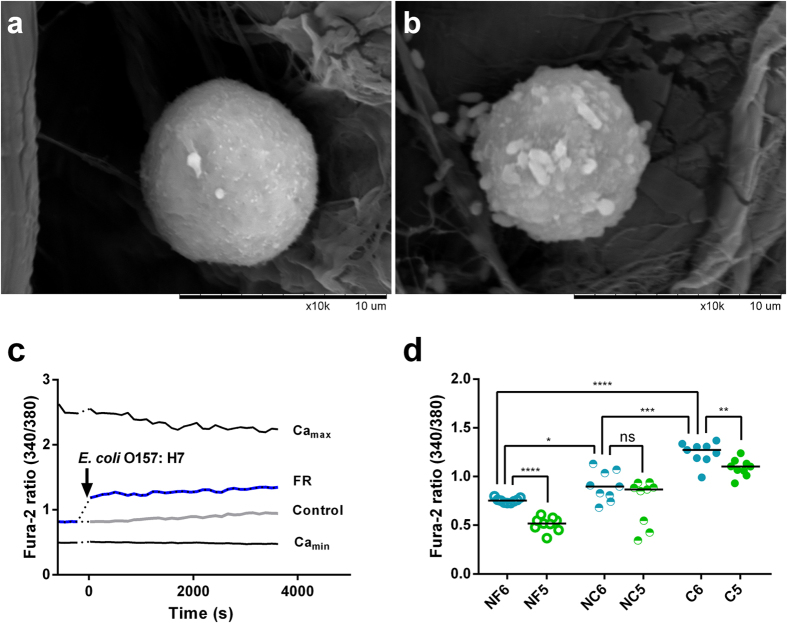
Optimization of the B cell biosensor. (a). SEM image of a B cell in the absence of any bacteria (×10000). (b). SEM image of a B cell with E.coli O157:H7 cells (×10000). (c). Real time response profile of Fura-2 340/380 ratio. (d). Comparison of the Fura-2 ratio for each group defined in the text. Data points represent the ratio of the stimulation by each concentration of E. coli O157:H7 (101-109 CFU/mL) in the group at the same time. Bars indicate the medians and p-value obtained by paired t-test. (two-tailed, nsp > 0.05, *p < 0.05, **p < 0.01, ***p < 0.001, ****p < 0.0001, n = 9) NF6: B cells (no Fura-2, Ca2+ and Mg2+ HBSS), 106 cells/mL. NF5: B cells (no Fura-2, Ca2+ and Mg2+ HBSS), 105 cells/mL. NC6: B cells (Fura-2, Ca2+ and Mg2+-free HBSS), 106 cells/mL. NC5: B cells (Fura-2, Ca2+ and Mg2+-free HBSS), 105 cells/mL. C6: B cells (Fura-2, Ca2+ and Mg2+ HBSS), 106 cells/mL. C5: B cells (Fura-2, Ca2+ and Mg2+ HBSS), 105 cells/mL.